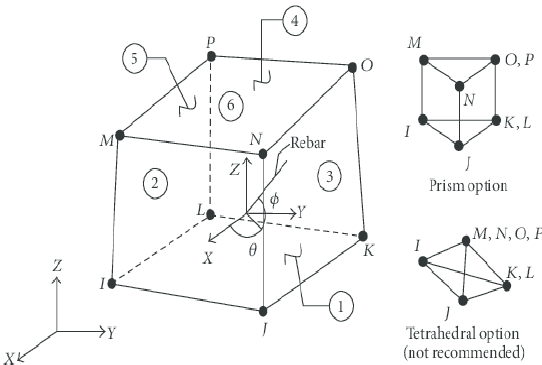
Figure 9. Schematic of Solid65 element.